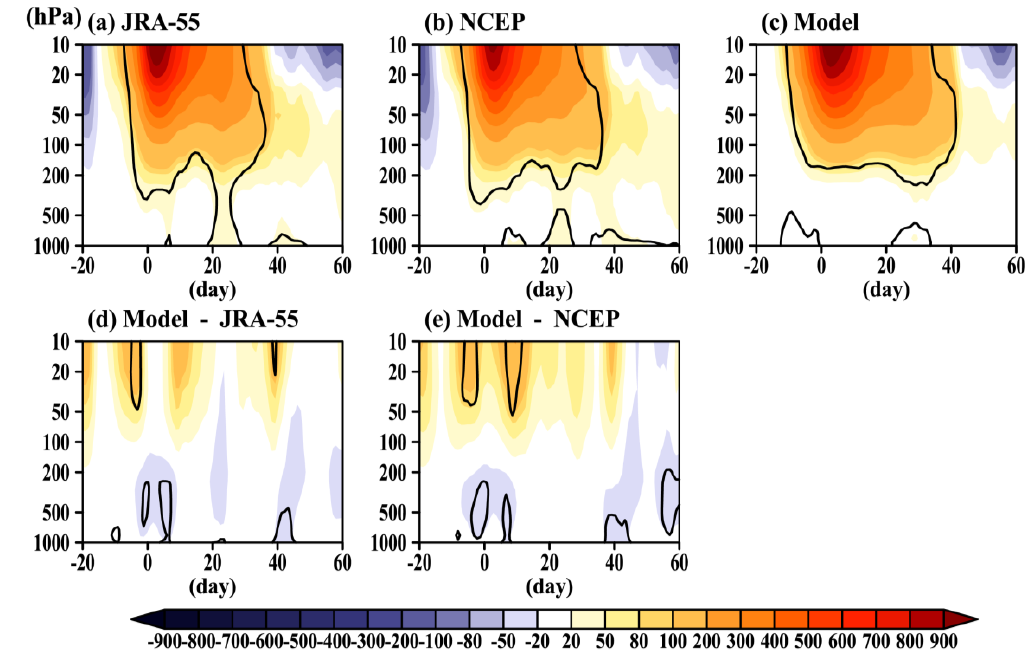
Figure 5. Same as in Figure 4, but for the zonal mean geopotential height anomalies area-averaged over the polar cap region from 60 – 90° N (shadings; units: gpm).